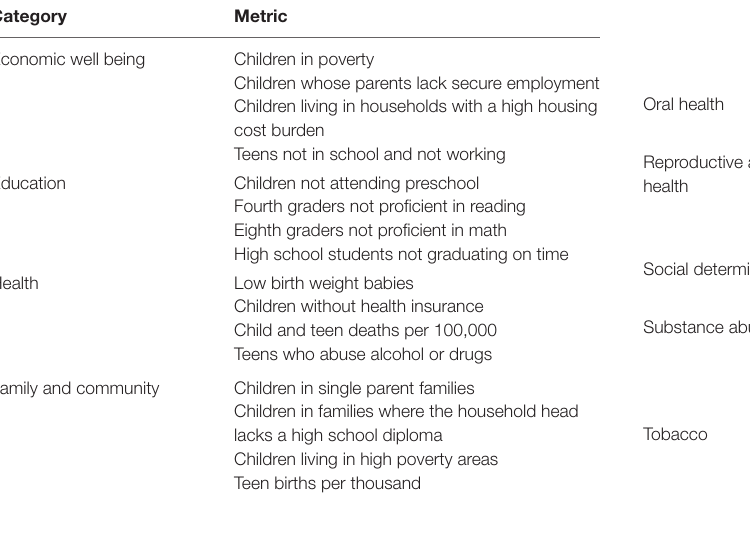
TABLe 7 | Overall well being of children in the United States assessed by Kids Count.